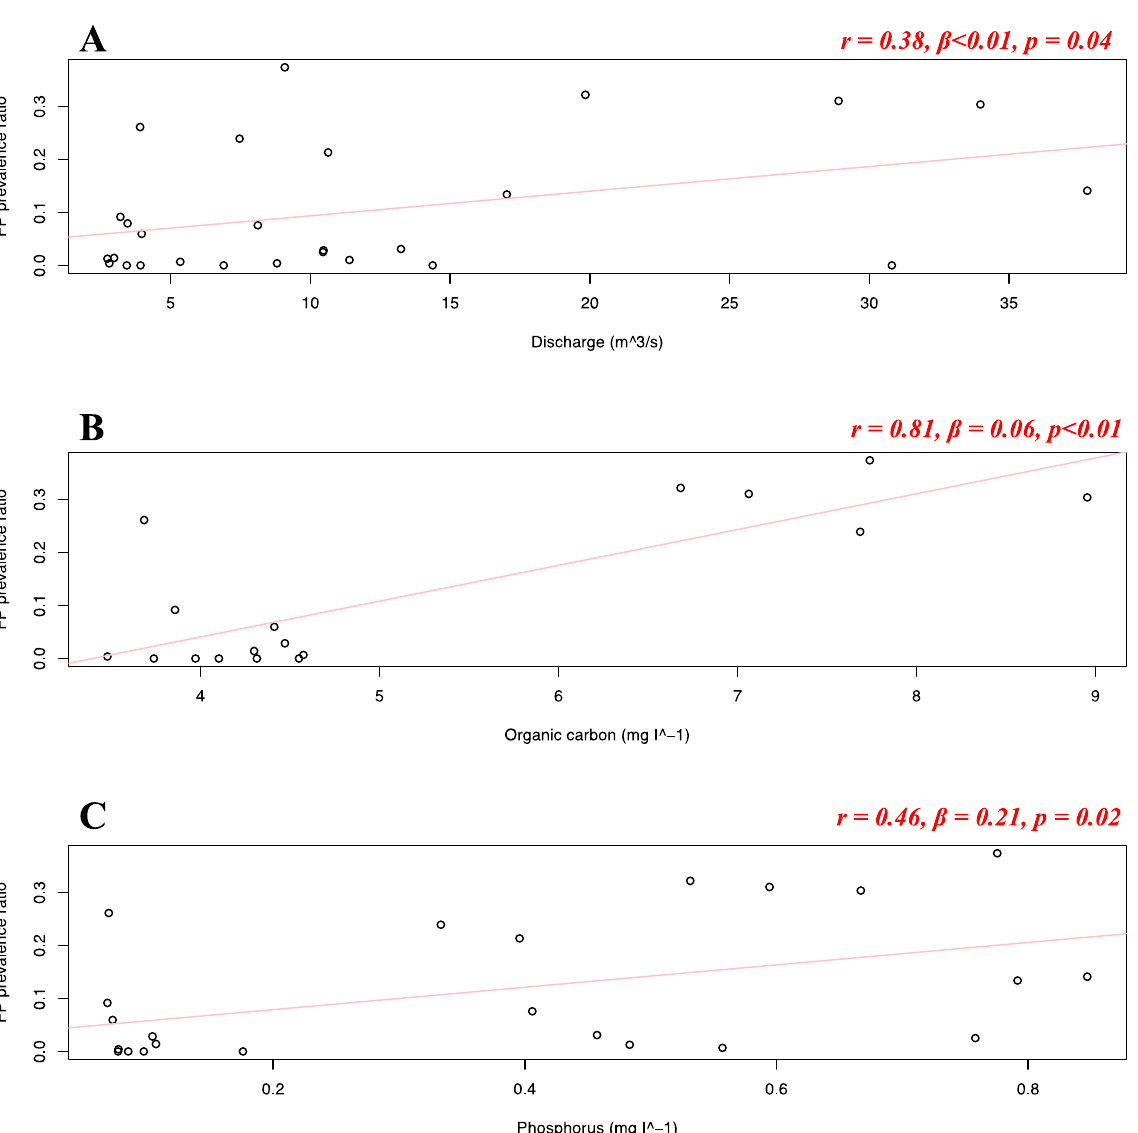
Figure 9. Texas dataset FP prevalence and discharge and nutrients variables. Scatterplots with fitted regression lines representing the logistic regression output from the response variables versus predictor variables in the Texas dataset: FP prevalence ratio on the y -axis versus discharge ( A ), organic carbon ( B ), and phosphorus ( C ). Pearson correlation ( r ), beta-coefficient ( β ), and p -value ( p ) are reported for each predictor variable on the top right of the respective plot. Significant relationships are highlighted in red.